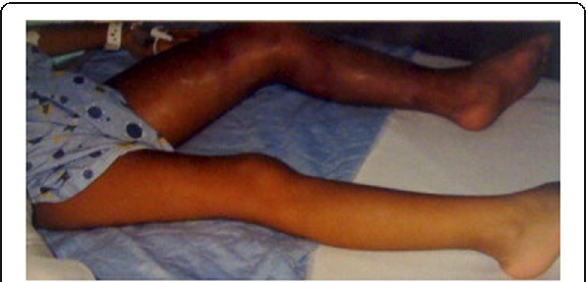
Fig. 1 5-year-old female with history of May-Thurner syndrome presenting with acute left lower extremity DVT and skin changes characteristic of phlegmasia cerulea dolens. [Image adapted from Kuo I, Smith J, Abou-Zamzam AM Jr. A multimodal therapeutic approach to phlegmasia cerulea dolens in a pediatric patient. J Vasc Surg. 2011. Jan;53(1):212 – 5. doi: https://doi.org/10.1016/j.jvs.2010.07. 067. Epub 2010 Sep 26. PubMed PMID: